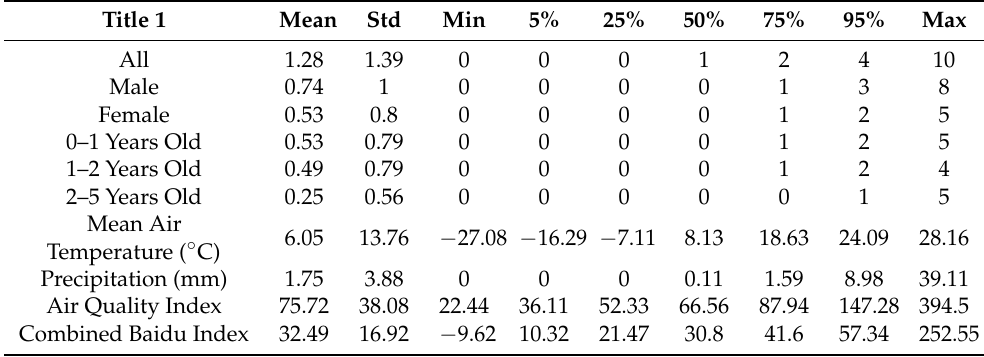
Table 1. Descriptive statistics of daily number of infection cases of each group, and the selected four external